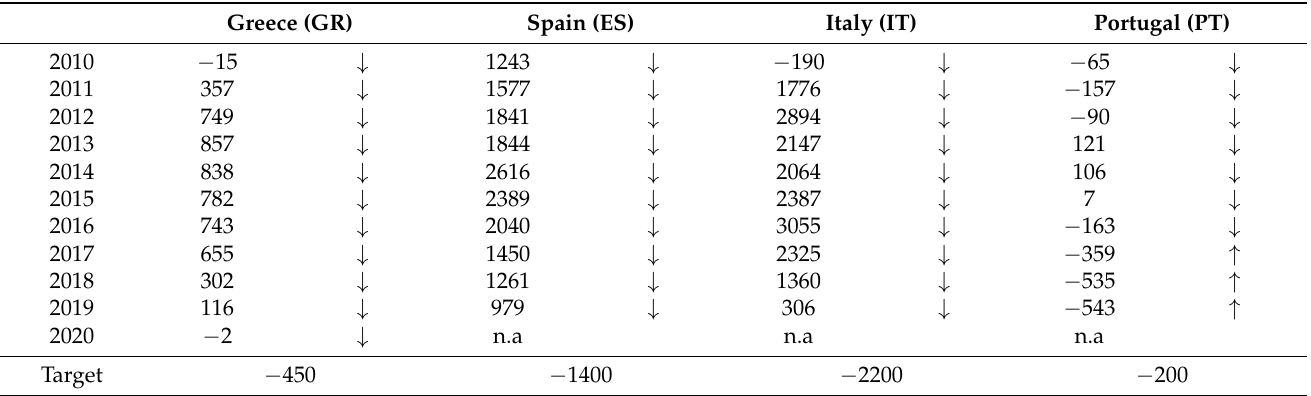
Table 2. People at risk of poverty or social exclusion, 2010–2020, cumulative difference from 2008